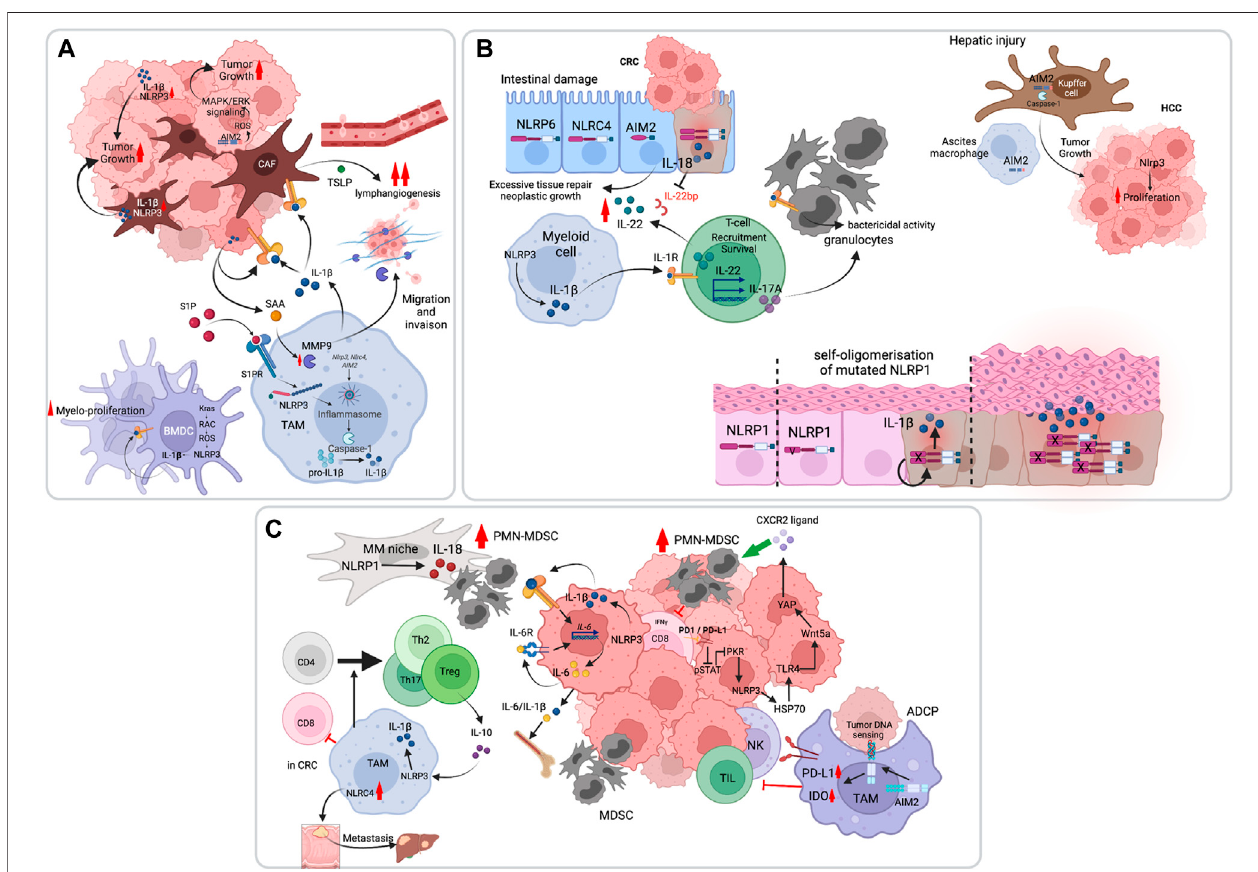
FIGURE2 | Pro-tumoral functions ofthe in fl ammasomepathway. (A) Thein fl ammasome, primarily NLRP3, promotes tumor cell survival, proliferation and invasion through IL-1 β . In fl ammasome-independent functions of AIM2 have also been demonstrated, in which AIM2 controls mitochondrial dynamics and activate oncogenic ERK activation through reactive oxygen species (ROS). (B) The in fl ammasome can promote tumorigenesis through induction of a chronic in fl ammatory states. In the intestine, both IL-18 and IL-1 β converge on IL-22 production which drives intestinal epithelial cell hyperproliferation. The chronic in fl ammatory state isalso enacted by IL-17 production which recruits granulocytes to amplify the response. In the liver, hepatic injury isassociated withAIM2 in fl ammasome activation both in Kupffer cells and in macrophages of the ascitic fl uid. IL-1 β in this case promotes hepatocytes hyper-proliferation. In the skin, germ-line mutations in NLRP1 result in chronic in fl ammation and tumorigenesis. (C) The in fl ammasomes can indirectly favor tumor development by suppressing anti-tumor immunity. IL-1 β was shown to enhance myeloid-derived suppressor cells (MDSC) recruitment to the tumor site and to promote T cell tolerogenic differentiation.